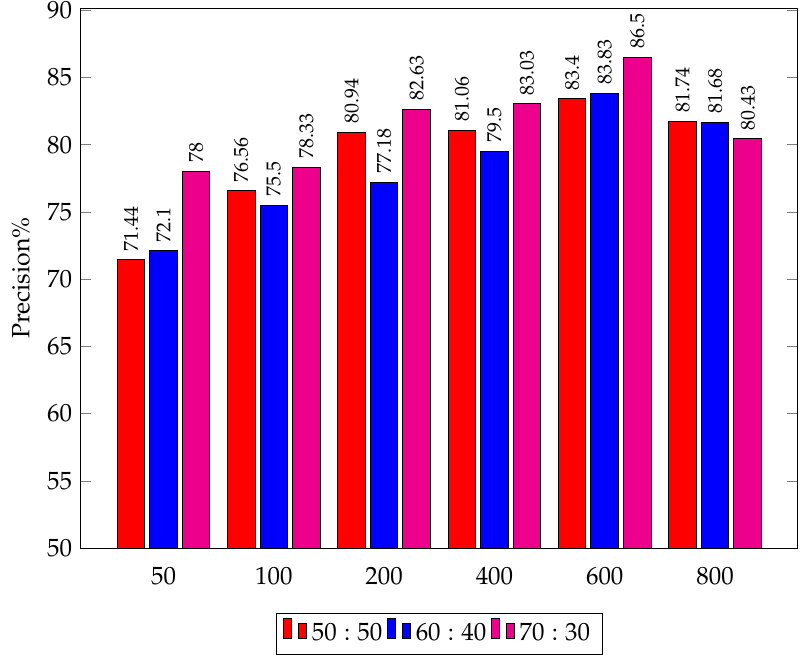
Figure 19. Average precision of the proposed RGSIR on visual vocabulary of different sizes using different training test